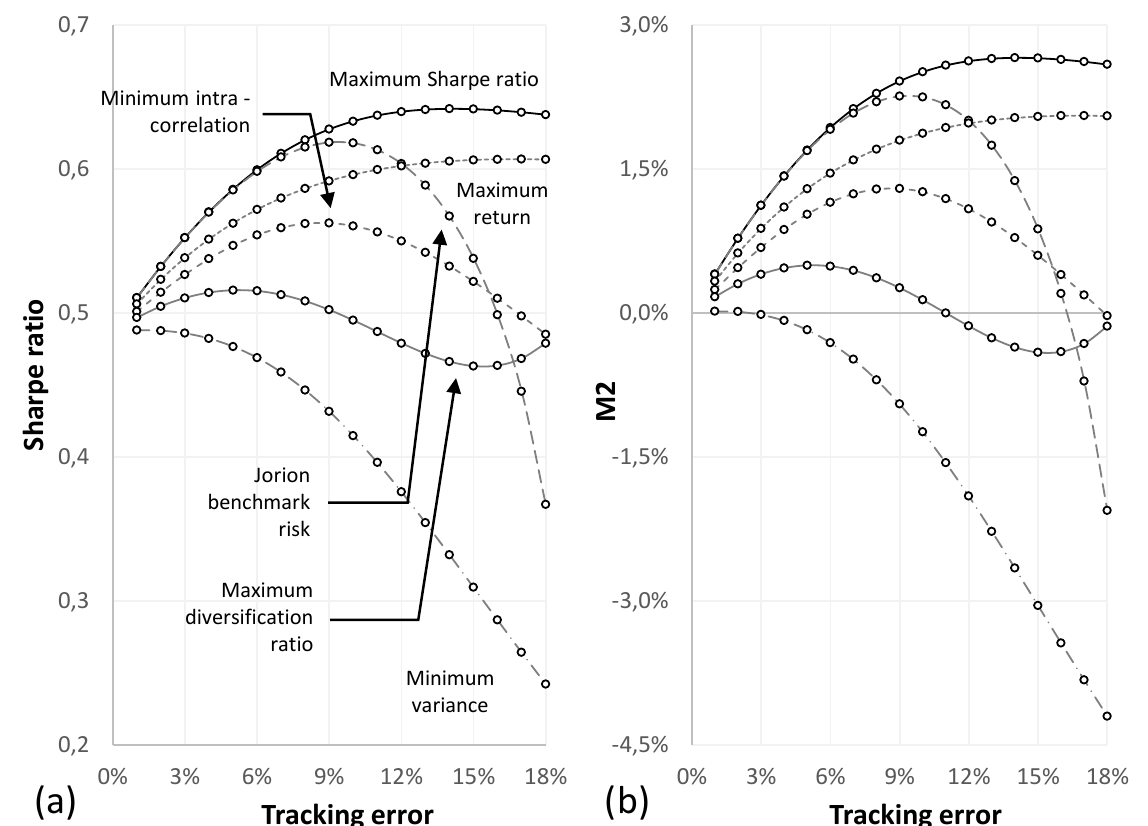
Figure 6. Performance evaluation of the six portfolio strategies with respect to their (a) Sharpe ratios and (b) M 2 ratios for incremental increases in